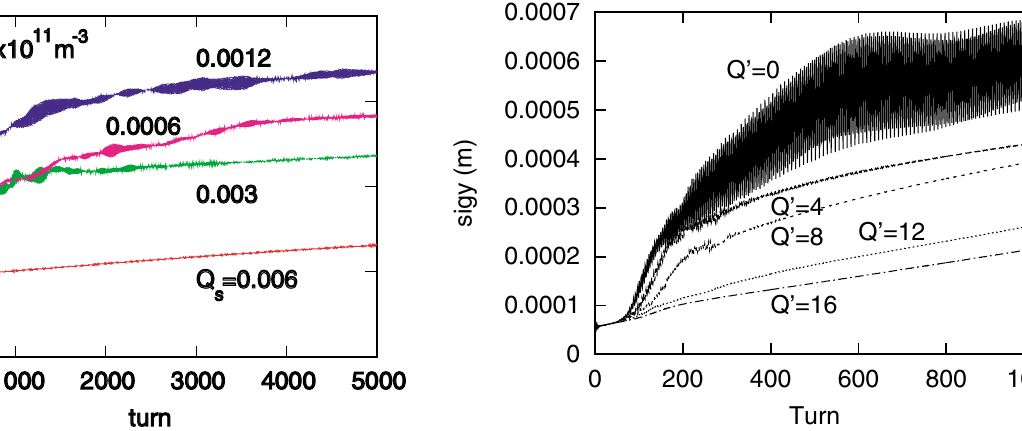
FIG. 41. Vertical rms beam-size growth of a KEKB bunch over 1000 turns for different values of chromaticity Q the PEHTS code [42,85].